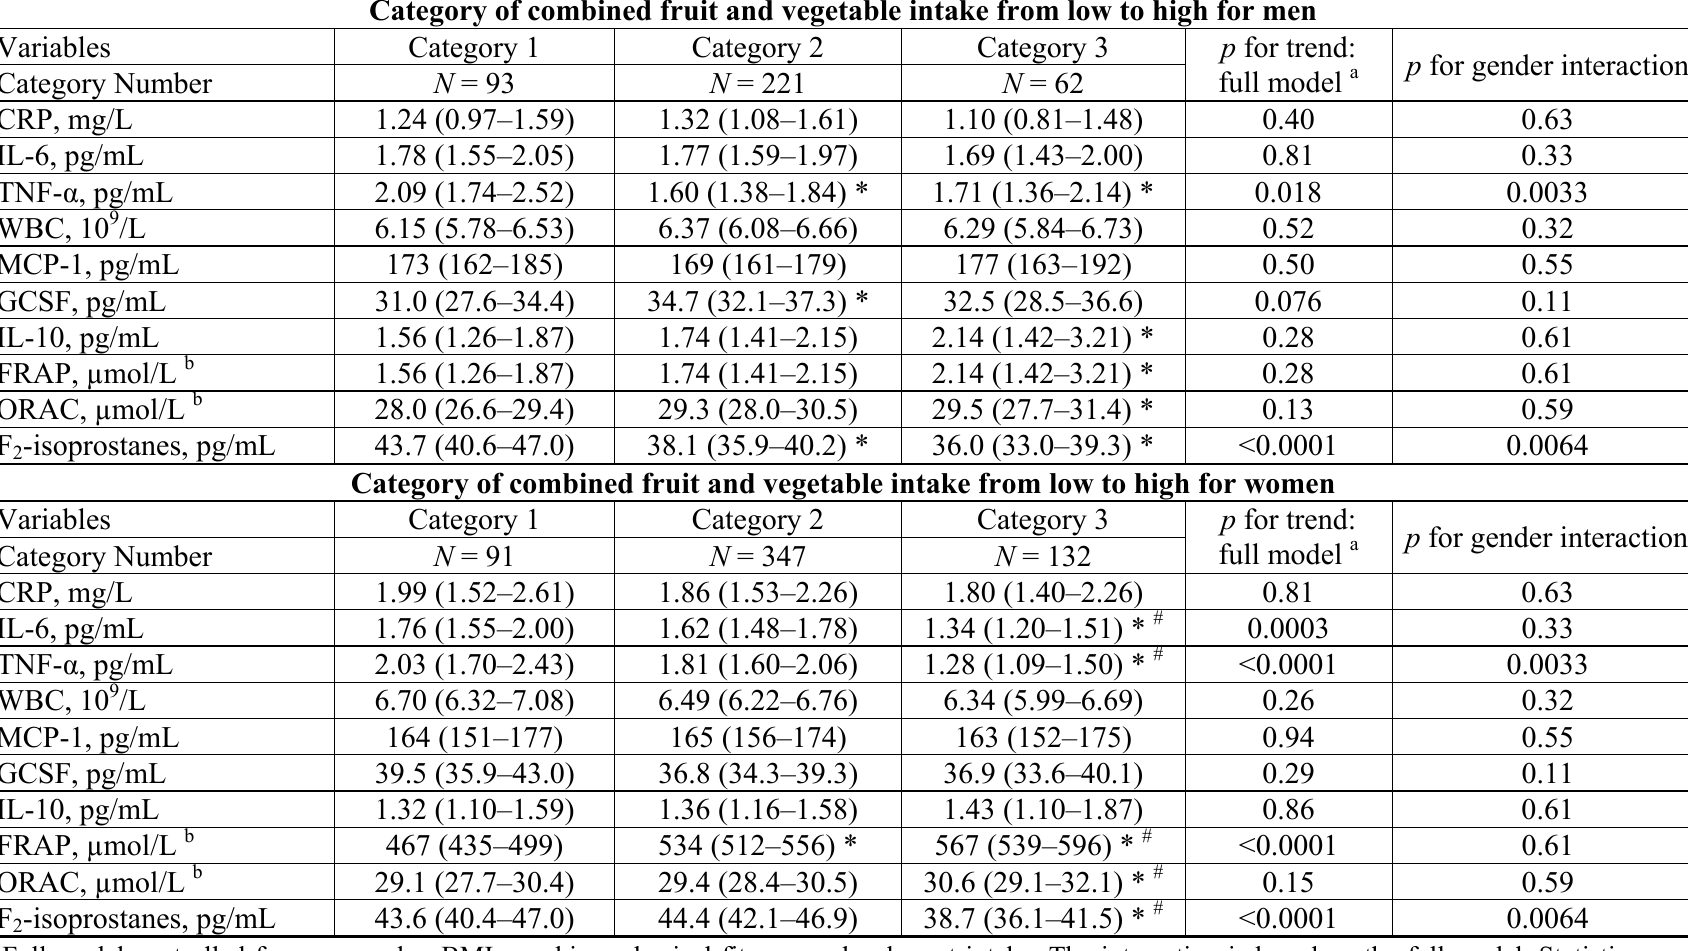
Table 5. Subgroup analysis of outcome characteristics for men and women (least square mean (95% confidence interval)) by category of combined fruit and vegetable intake category in a community